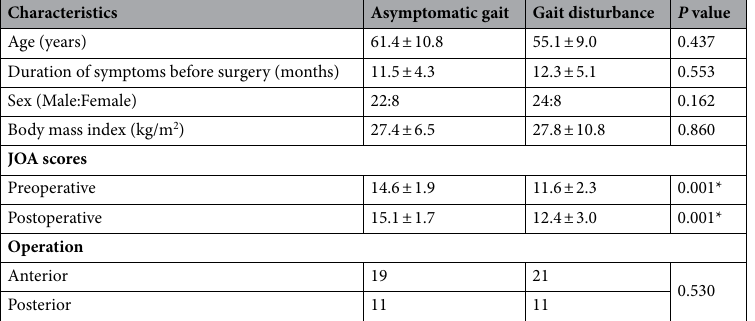
Table 1. Patient characteristics of asymptomatic gait and gait disturbance groups. JOA Japanese Orthopedic Association. * P < 0.05.